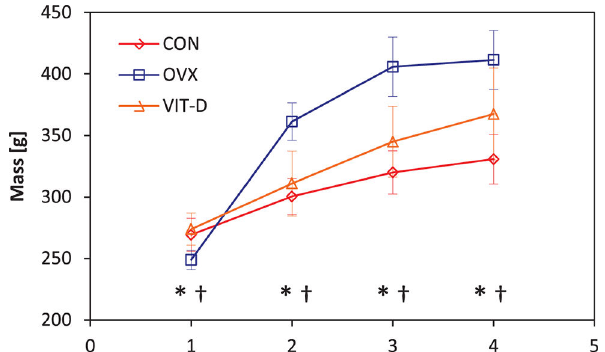
Figure 5. Body mass changes over the 4 months study period in CON, OVX and VIT-D groups (* indicates significance between CON and OVX groups, ** denotes significance between CON and VIT-D groups, † indicates significance between the OVX and VIT-D